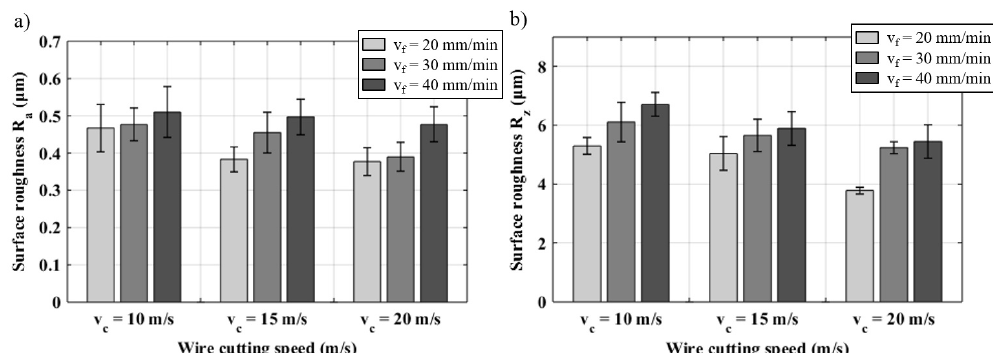
parameter and b) R parameter. a z